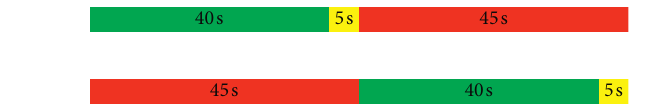
Figure 7: The traffic signal timing. Green time, amber time, and red time are equal to 40s, 5s, and 45s, respectively.